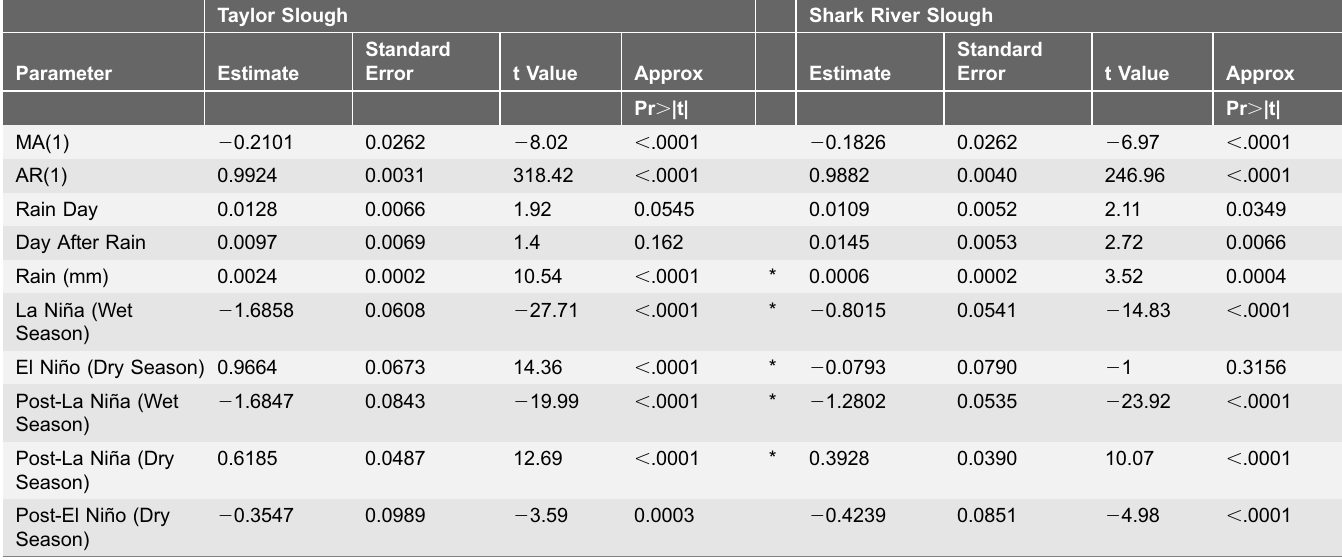
Table 7. Parameter estimates from ARIMA models of the daily water index by